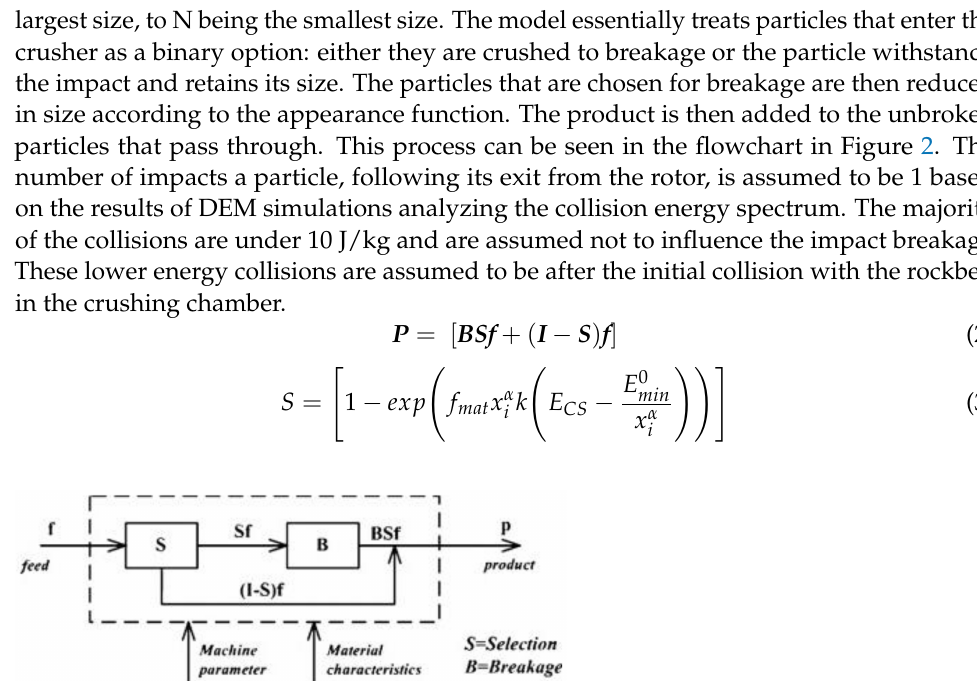
Figure 2. The selection–breakage process was used to determine the product generated from the feed [10].